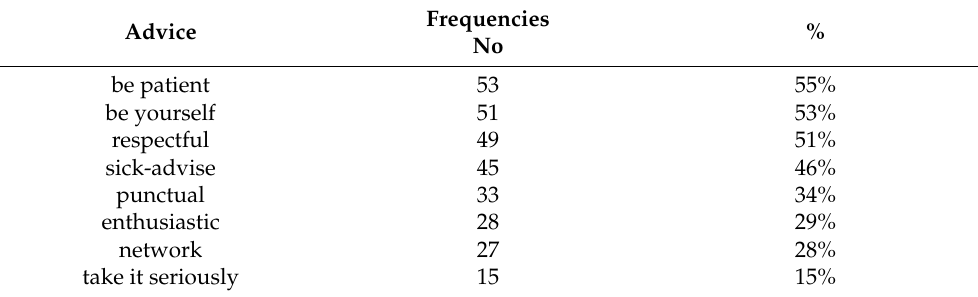
Table 6. Advice for future interns.